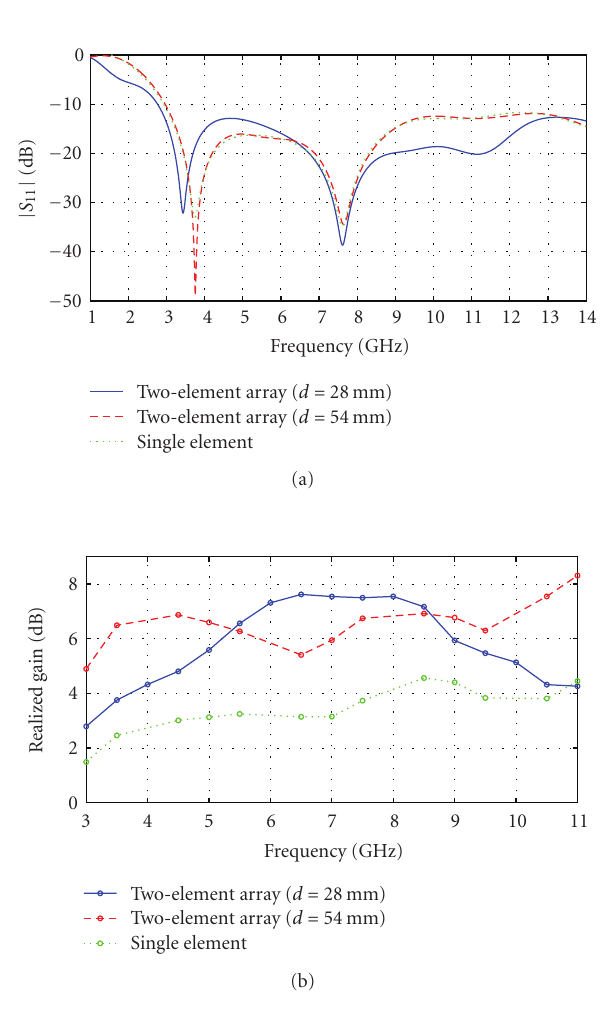
Figure 8: Simulated (a) | S 11 | and (b) realized gain curves of the two-element UWB array at di ff erent element spacing values d com- pared to a single antenna